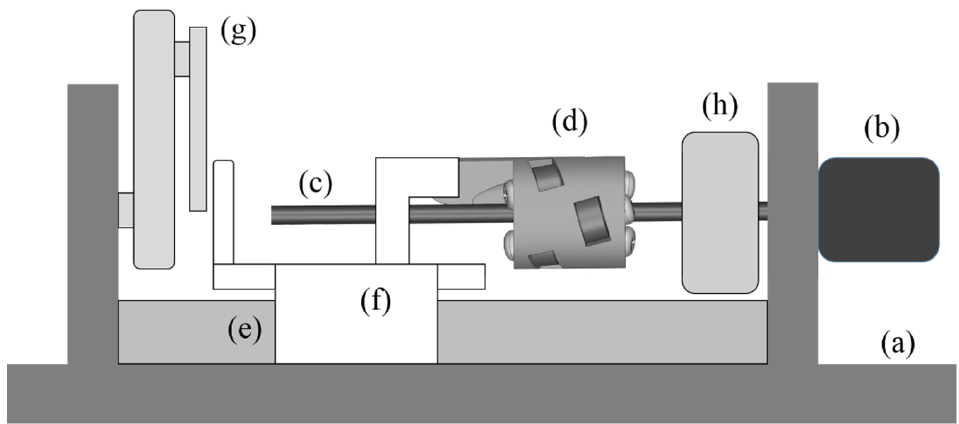
Figure 10. Schematic side view of the TLBS experimental setup: ( a ) Hardware base; ( b ) Motor; ( c ) TLBS shaft; ( d ) TLBS; ( e ) Linear guide; ( f ) Moving part connecting with TLBS; ( g ) Force sensor; ( h ) Torque